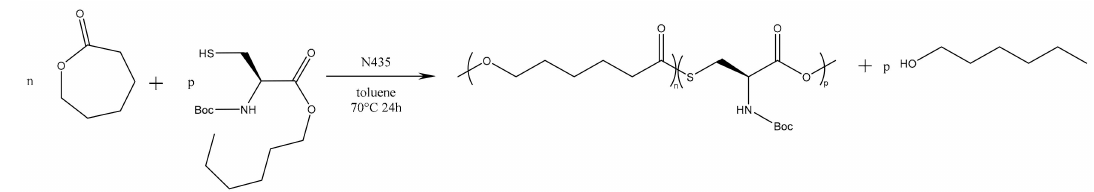
Figure 2. Second polymerization strategy based on the use of N -Boc protected cysteine hexyl ester.